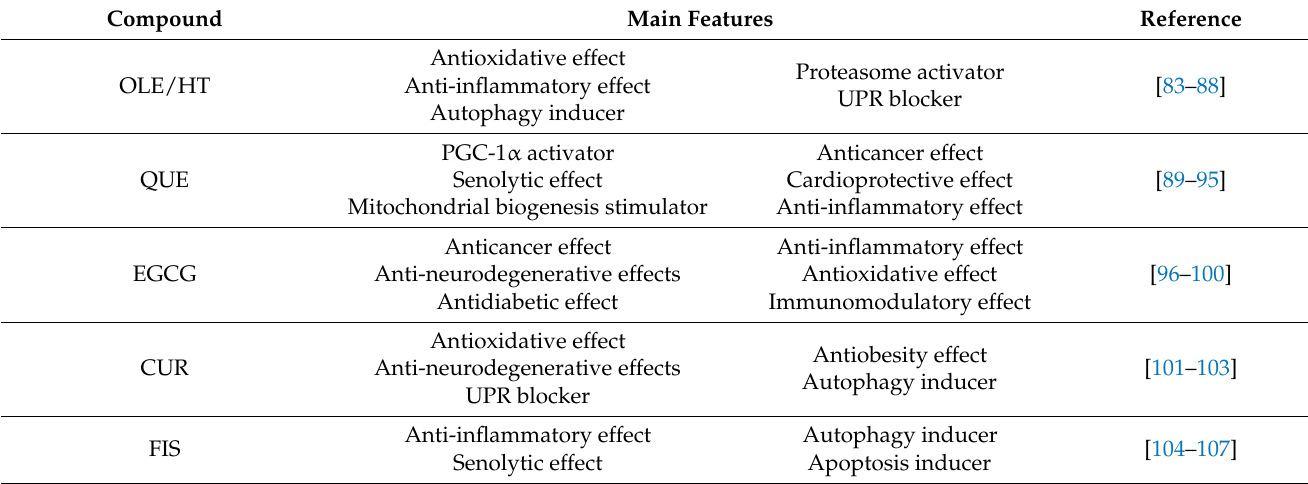
Table 1. Main effects of natural vegetable products against aging and metabolic